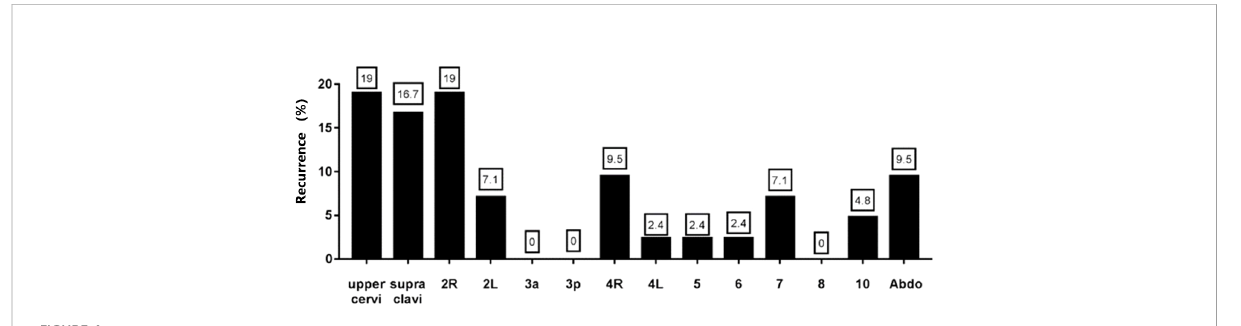
FIGURE 4 Lymph node metastasis pattern in patients with recurrent lymph